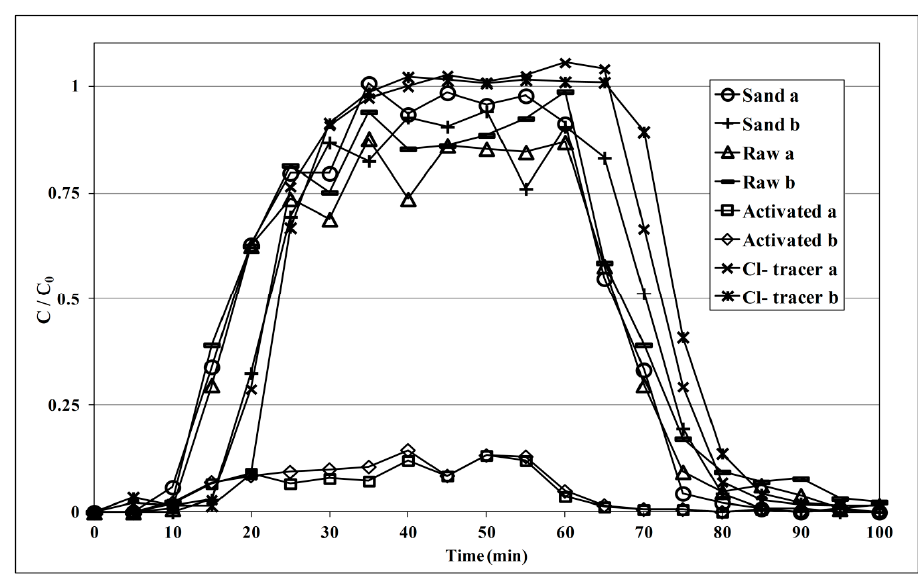
Figure 5. Breakthrough curves of E. coli from small column experiments carried out at a flow rate of 1 mL (0.20